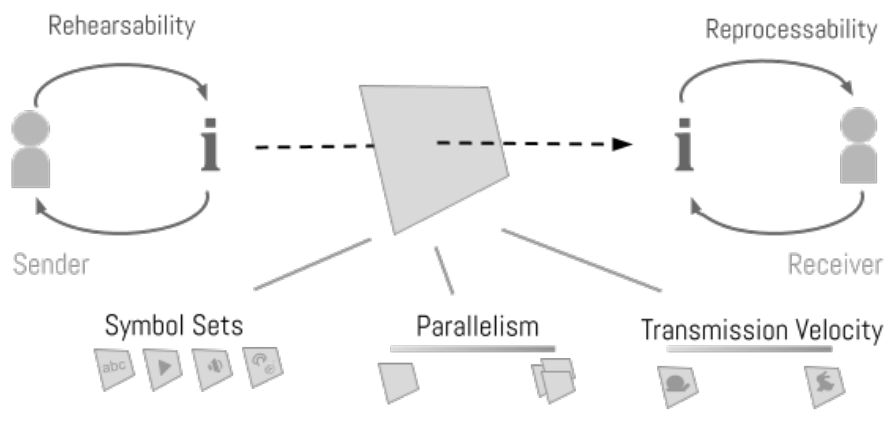
Figure 1. Media capabilities (adapted from